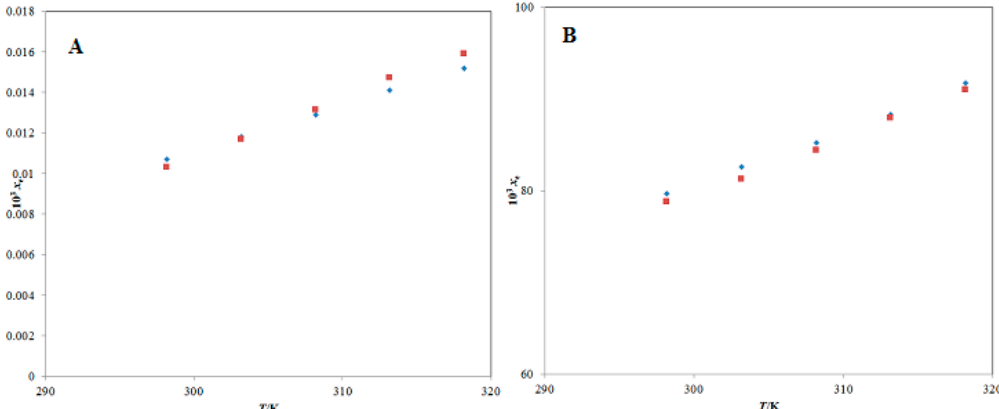
Figure 2. Comparison of mole fraction solubility of PPN in ( A ) pure water and ( B ) pure Transcutol-HP (THP) with reported solubilities at “ T = 298.2 K to 318.2 K”; the symbol shows the experimental mole fraction solubility of PPN in ( A ) pure water and ( B ) pure THP, and the symbol shows the reported solubilities of PPN in ( A ) pure water and ( B ) pure THP taken from reference [38].